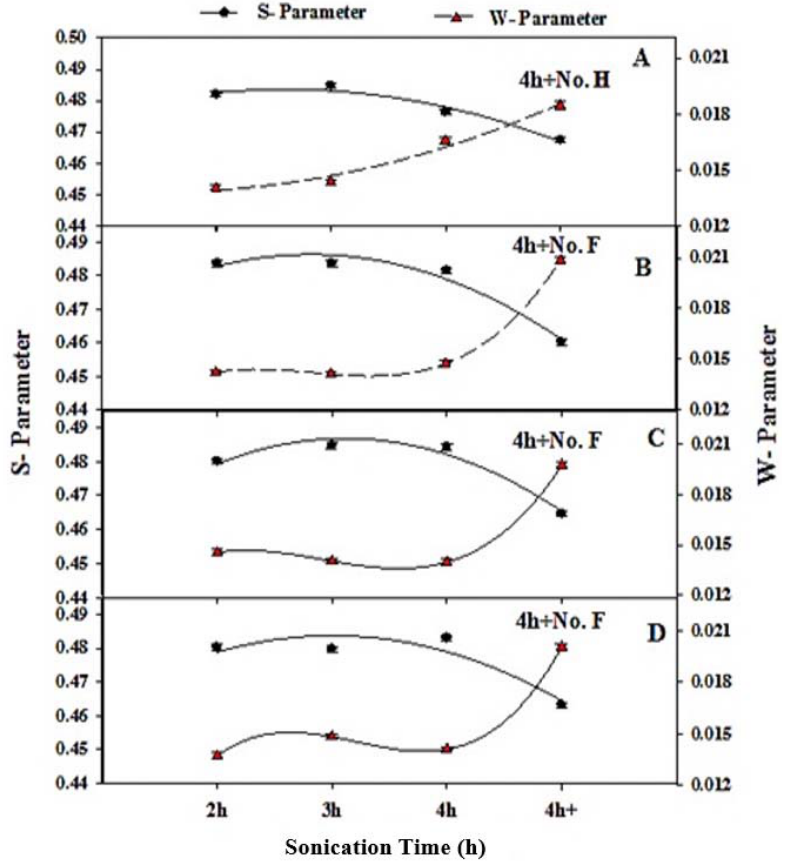
Figure 6. The variation of W–parameters at 7 g commercial silicon powder at sonication time (2, 3 and 4 h) with special conditions with different weights of KOH (wt.%): ( A ) at 6 wt.% KOH, ( B ) 4.5 wt.% KOH and ( C ) 3 wt.% KOH and ( D ) 5 g commercial silicon powder and 3 wt.% KOH.